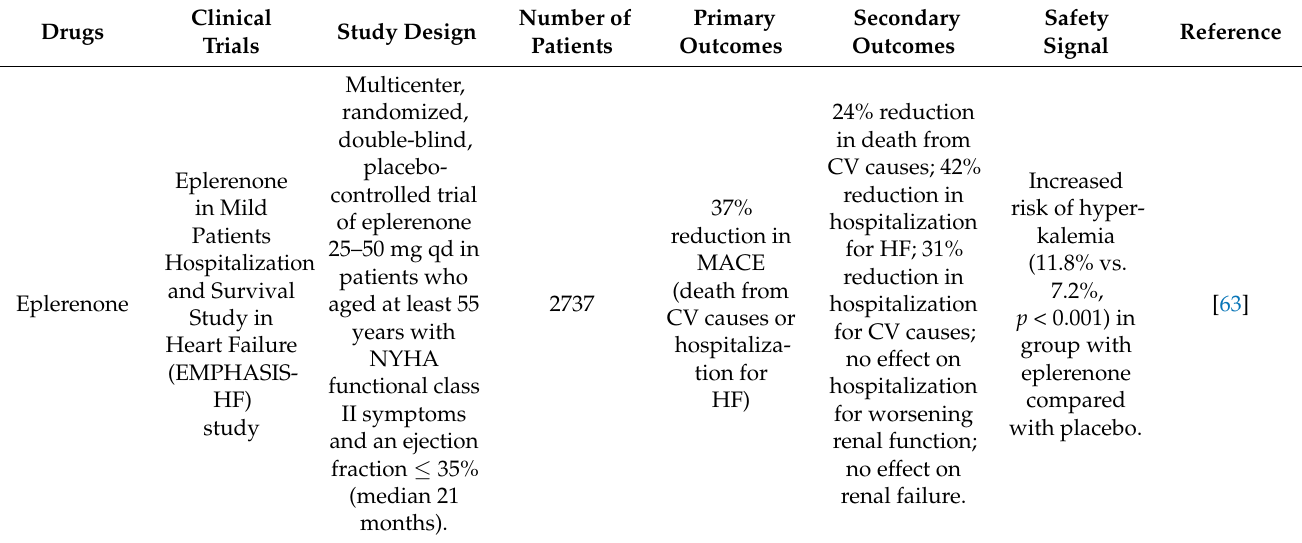
Table 1. Major clinical studies related to aldosterone